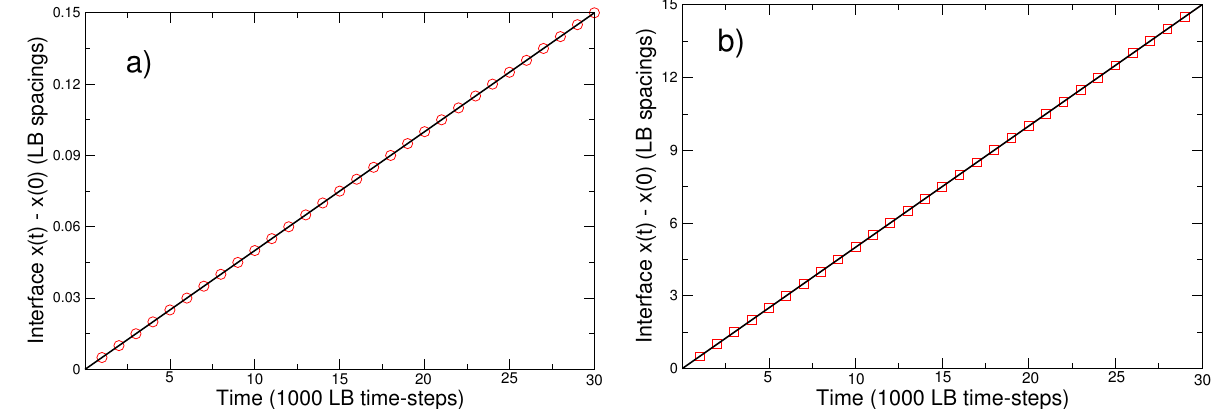
Figure 3. Comparison of numerical LB results (symbols) versus analytic result (lines) for the rapid kinetic reaction. In ( a ) the reaction rate is κ = 10 − 5 , and in ( b ) κ = 10 − 3 , while S = 0.5 for